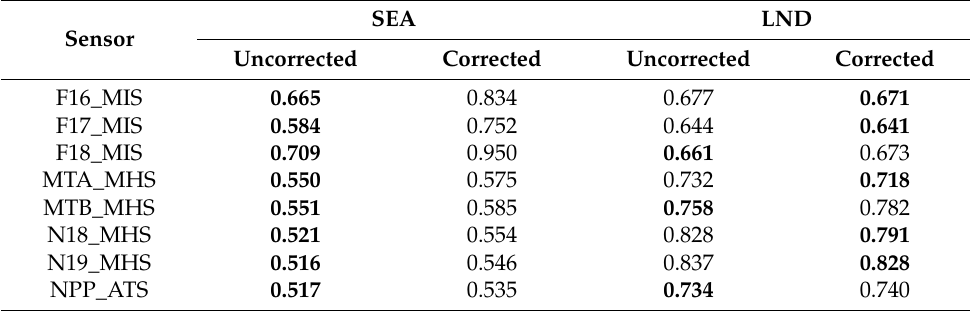
Table 3. The same as Table 2 except for RMSE. Sensor